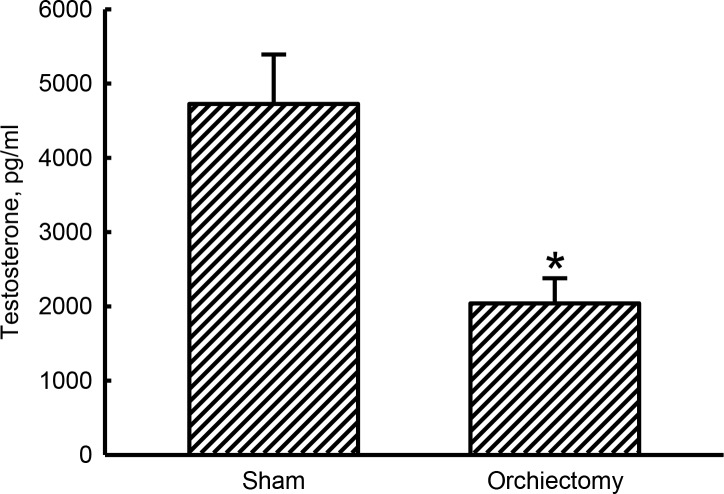
Effects of orchiectomy on reductions in testosterone levels.Male Wistar rats were subjected to sham operation or orchiectomy. Four weeks after surgery, blood samples were collected for analysis of plasma testosterone using an enzyme-linked immunosorbent assay. Each value represents the mean ± SD of three independent determinations. * Indicates that the value significantly (p < 0.05) differed from the sham group.